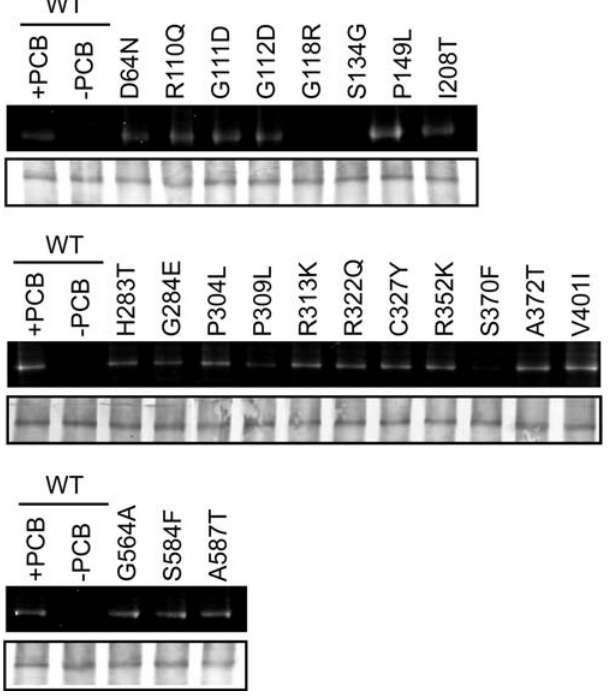
Figure 2. Chromophore Ligation to Mutant N651 Fragments. Results of zinc-blot (upper panels) and immunoblot (lower panels) analyses are shown. Crude extracts from Escherichia coli expressing the mutant N651 fragments were incubated with 5 m M PCB and separated by SDS-PAGE [23,37]. Immunoblot detection was performed using antiserum against chitin binding domain (New England Biolabs).